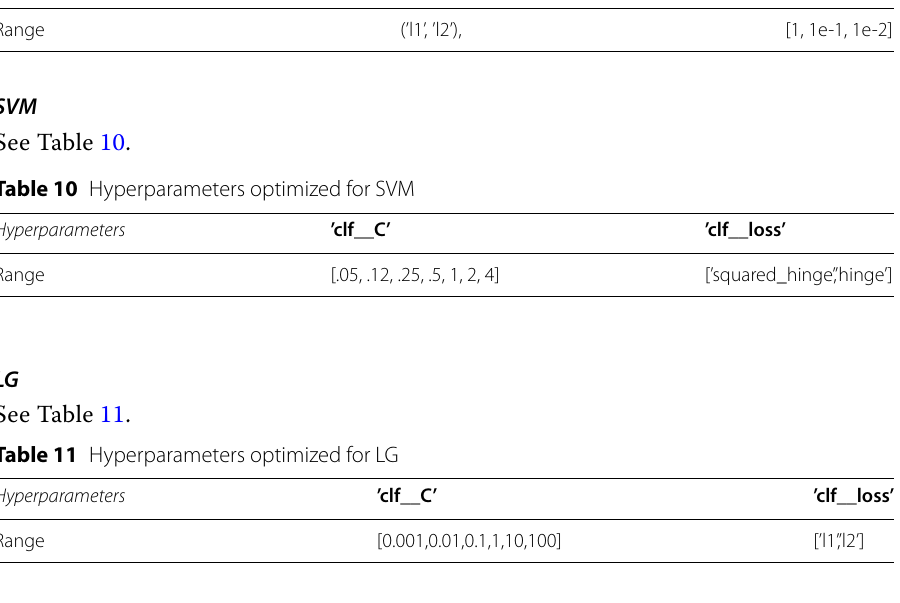
Table 9 Hyperparameters optimized for NB Hyperparameters